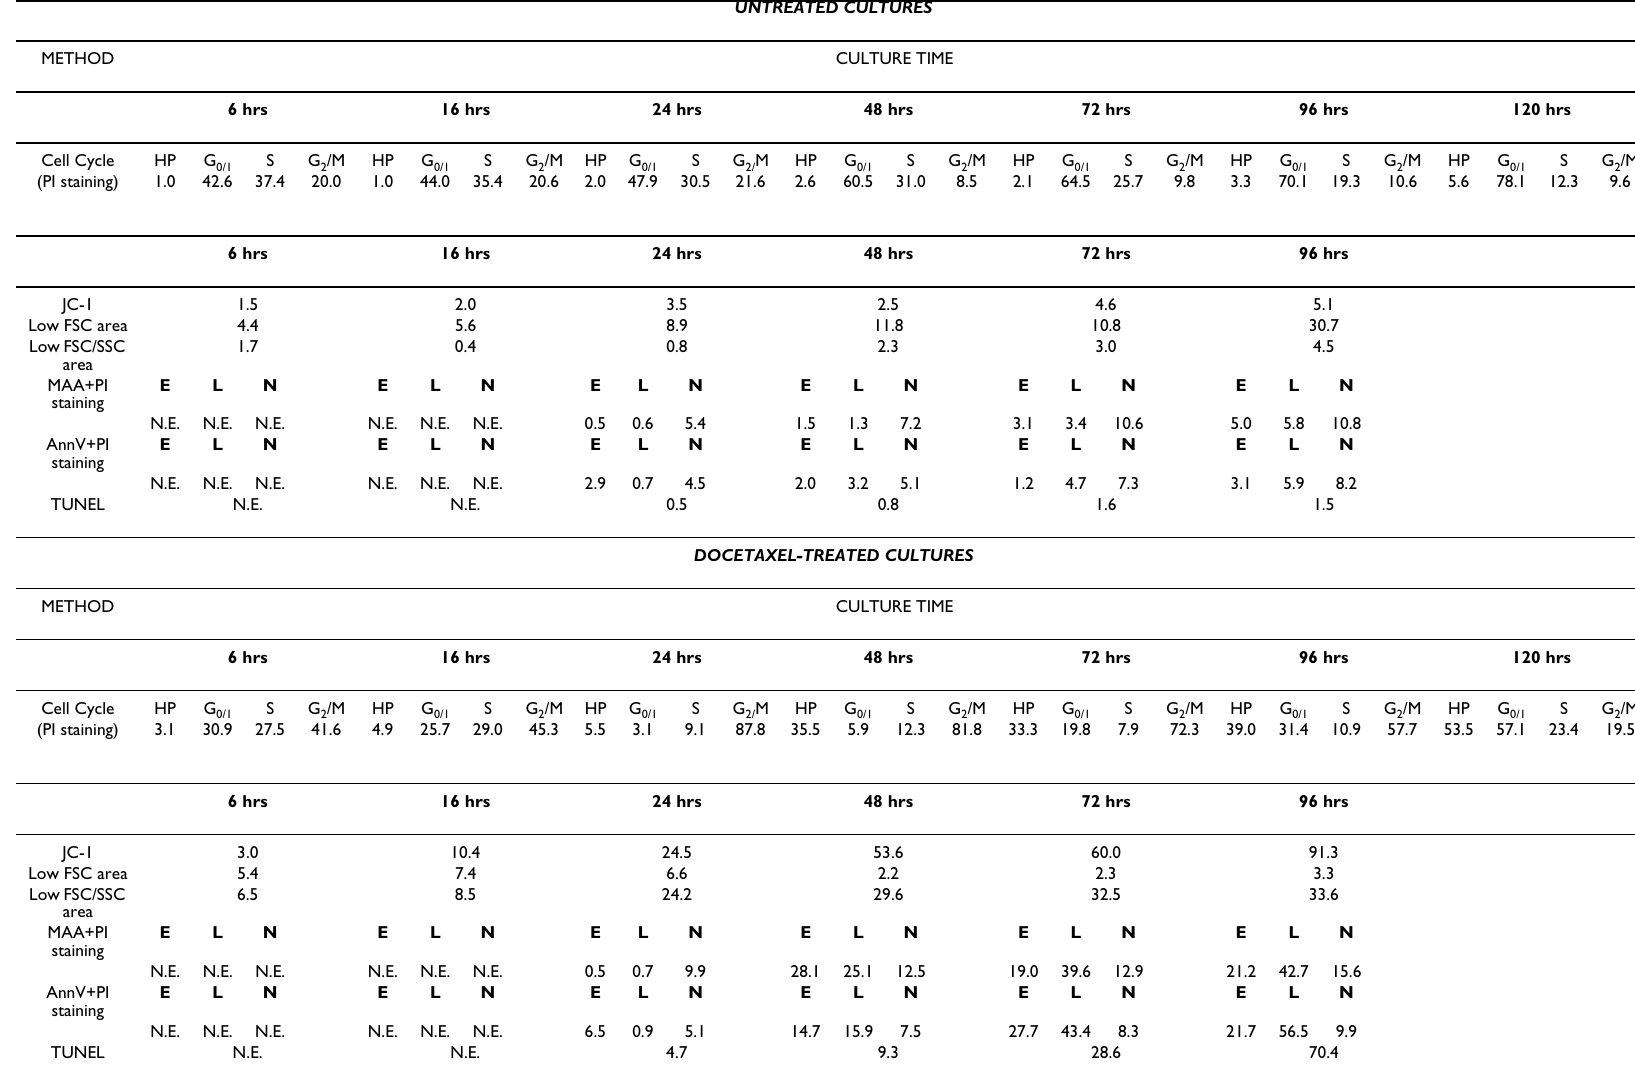
Table 1: Percentage of apoptotic cells: comparison of results obtained with different methods in HT 1376 cells